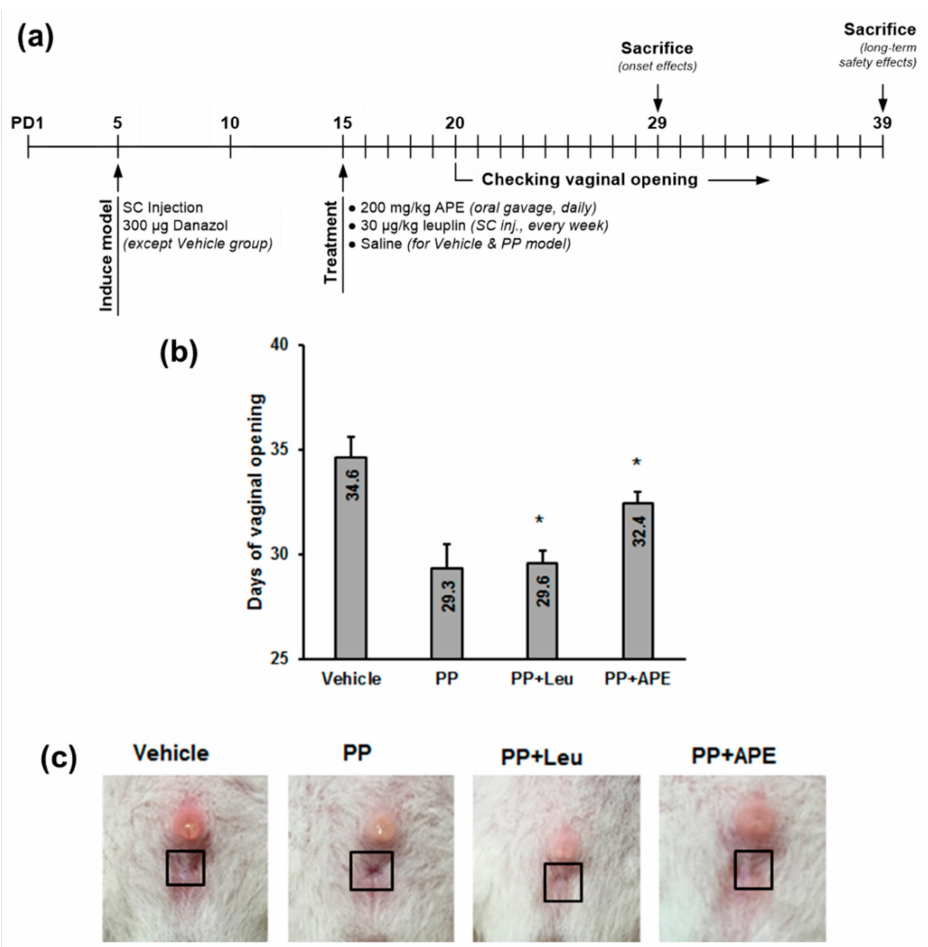
Figure 2. APE delayed vaginal opening in danazol-treated female rats. ( a ) Schematic representation of the experimental design. ( b ) Treatment with the APE extract delayed vaginal opening. ( c ) The representative images of vagina of rats in different experimental groups on postnatal day 29. * p < 0.05, compared to the PP